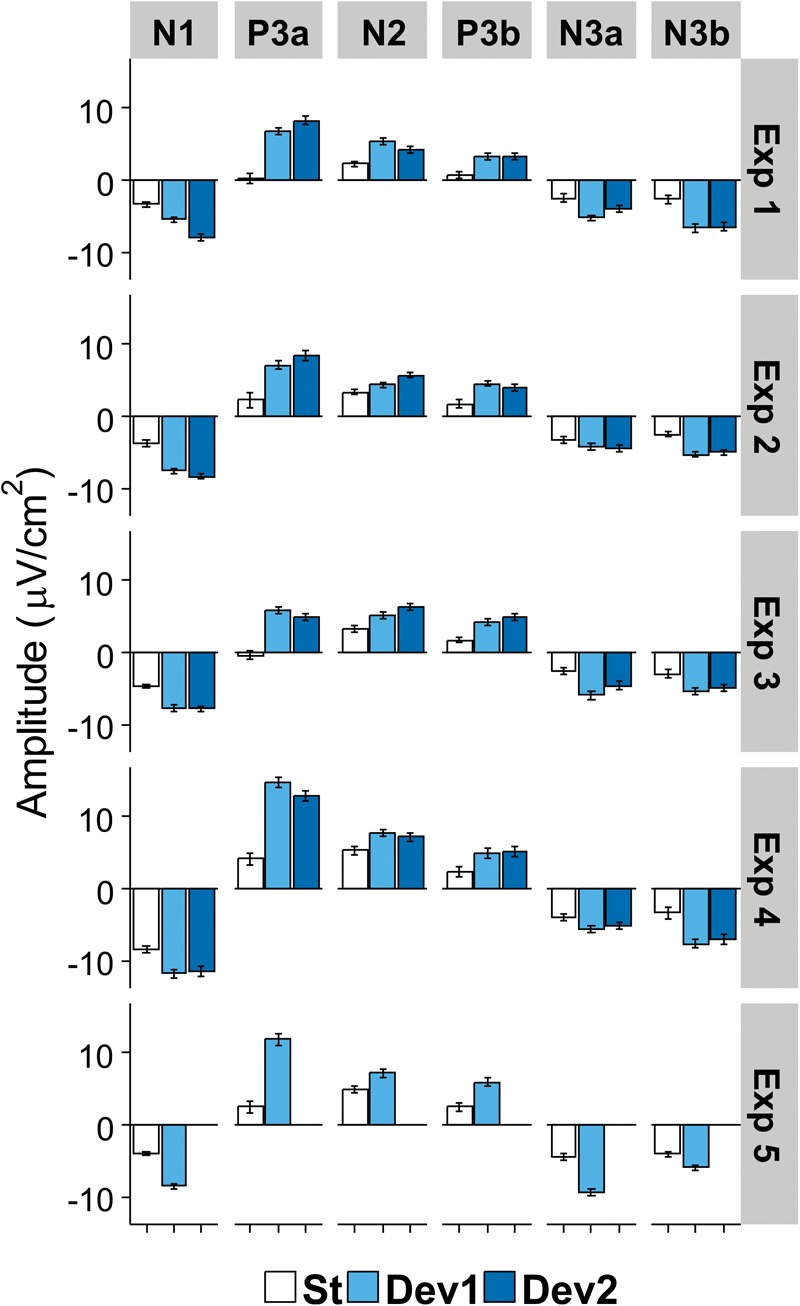
Mean amplitude of each ERP component in the region of its maximal expression (N1, frontocentral right; P3a, Cz; N2b, temporoparietal left; P3b, temporoparietal left; N3a (early), and N3b (late), frontocentral right). White columns, standard; light blue columns, Deviant 1 (or the only deviant in Experiment V); dark blue, Deviant 2. Bars show standard errors of means.